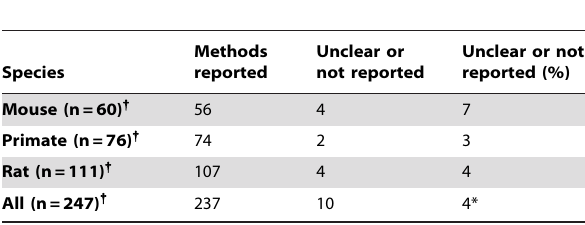
Table 16. Number of studies where the statistical method was not reported or was unclear.